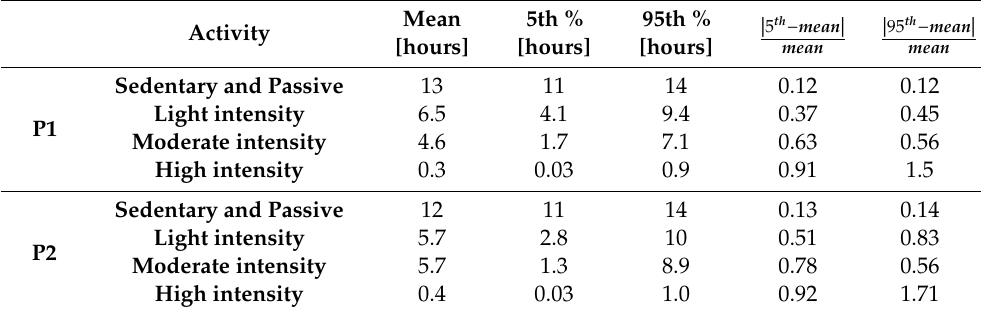
Table 2. Mean, 5th, and 95th percentile daily share of activity for P1 and P2, with calculated di ff erences between the percentiles and the mean, provided in the EPA Exposure Handbook